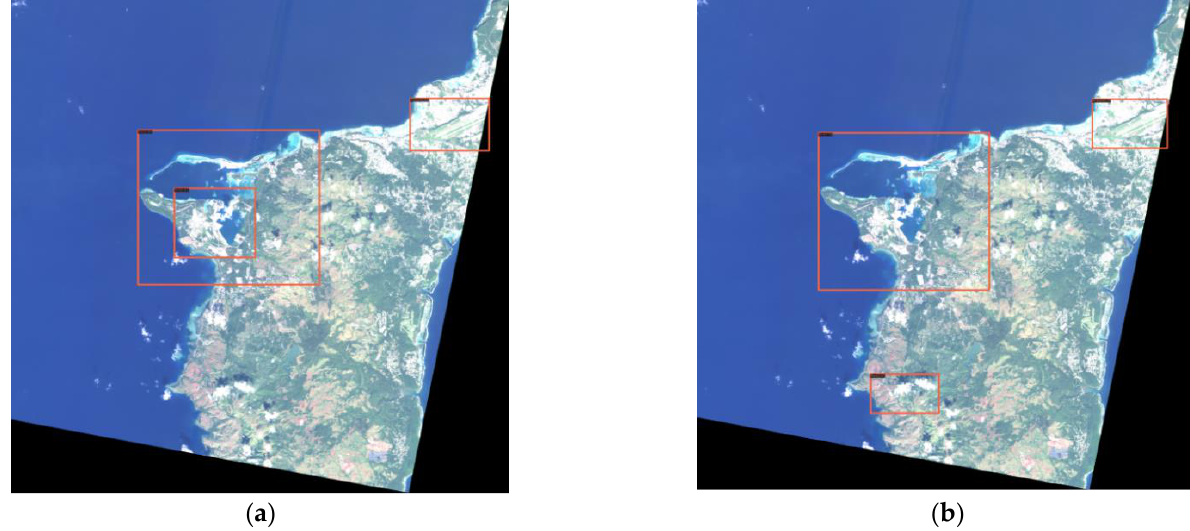
Figure 10. Comparison of multi-target prediction errors: ( a ) Swin-HSTPS ’ s multi-type target prediction results; ( b ) Swin Transformer ’ s multi-type target prediction results (incorrect mark in the lower left corner).